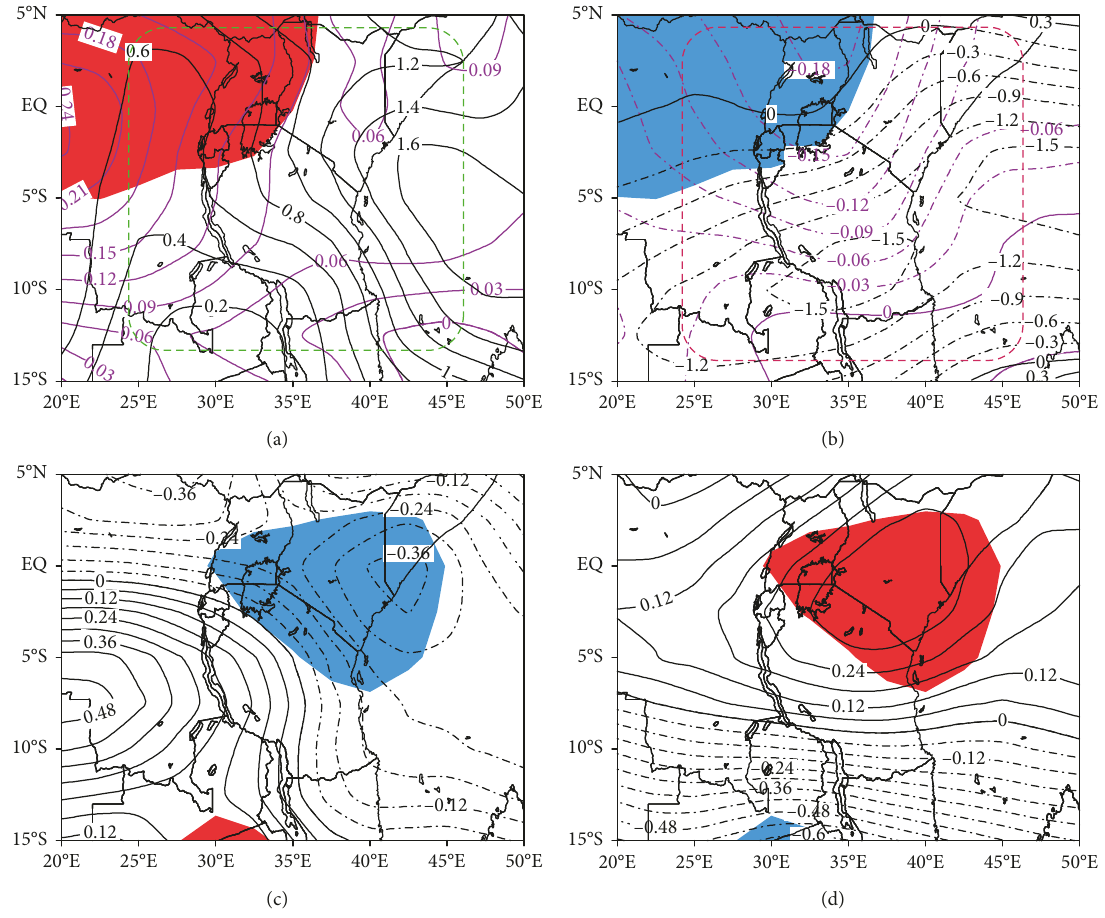
Figure 10: Composite anomaly distribution fields for the air temperature ( ° C) at 300hPa level (brown contour) and 200hPa level zonal components of the wind pattern in ms anomalous (a, c) and (b, d) during suppressed periods of HREs. The shading (from a–d) denotes significant areas at 95% confidence